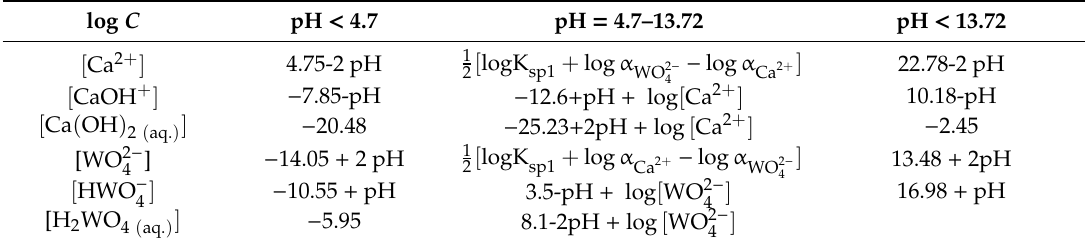
Table 3. Relationship between the concentration ( C ) and